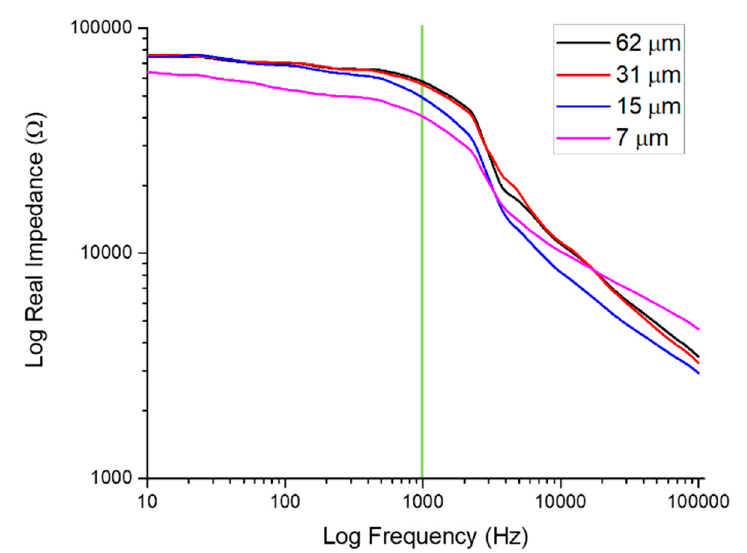
Figure 13. Full spectrum impedance measurements of several IDEs of varying pitch. The electrophysiologically significant frequency of 1 kHz (green line) reports impedances from approximately 39 k Ω (7 µm) to 56 k Ω (62 µm).